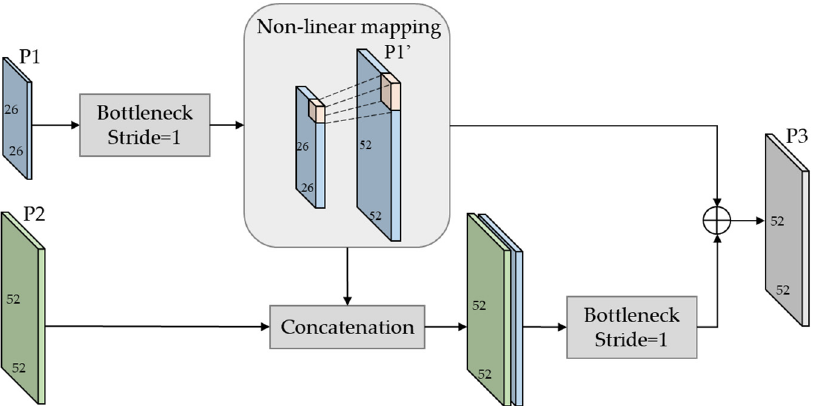
Figure 6. This is the structure of the feature fusing module (FFM). P1 and P2 denotes the feature pyramid layers on FPN. P3 is be obtained with main semantic fearure map P1 and the location reference feature.